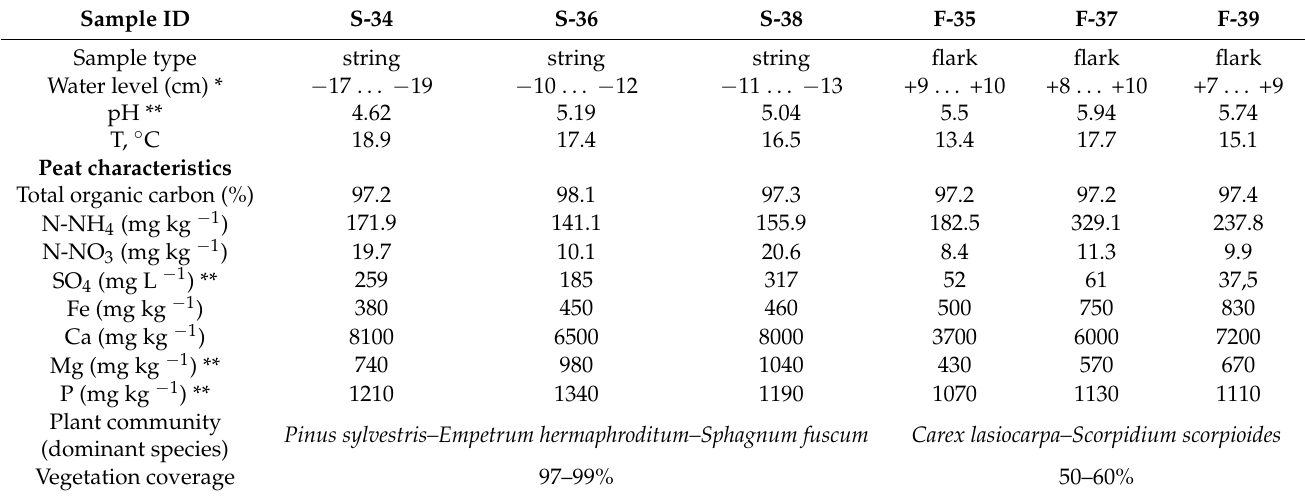
Table 1. Physical and chemical characteristics of sampling